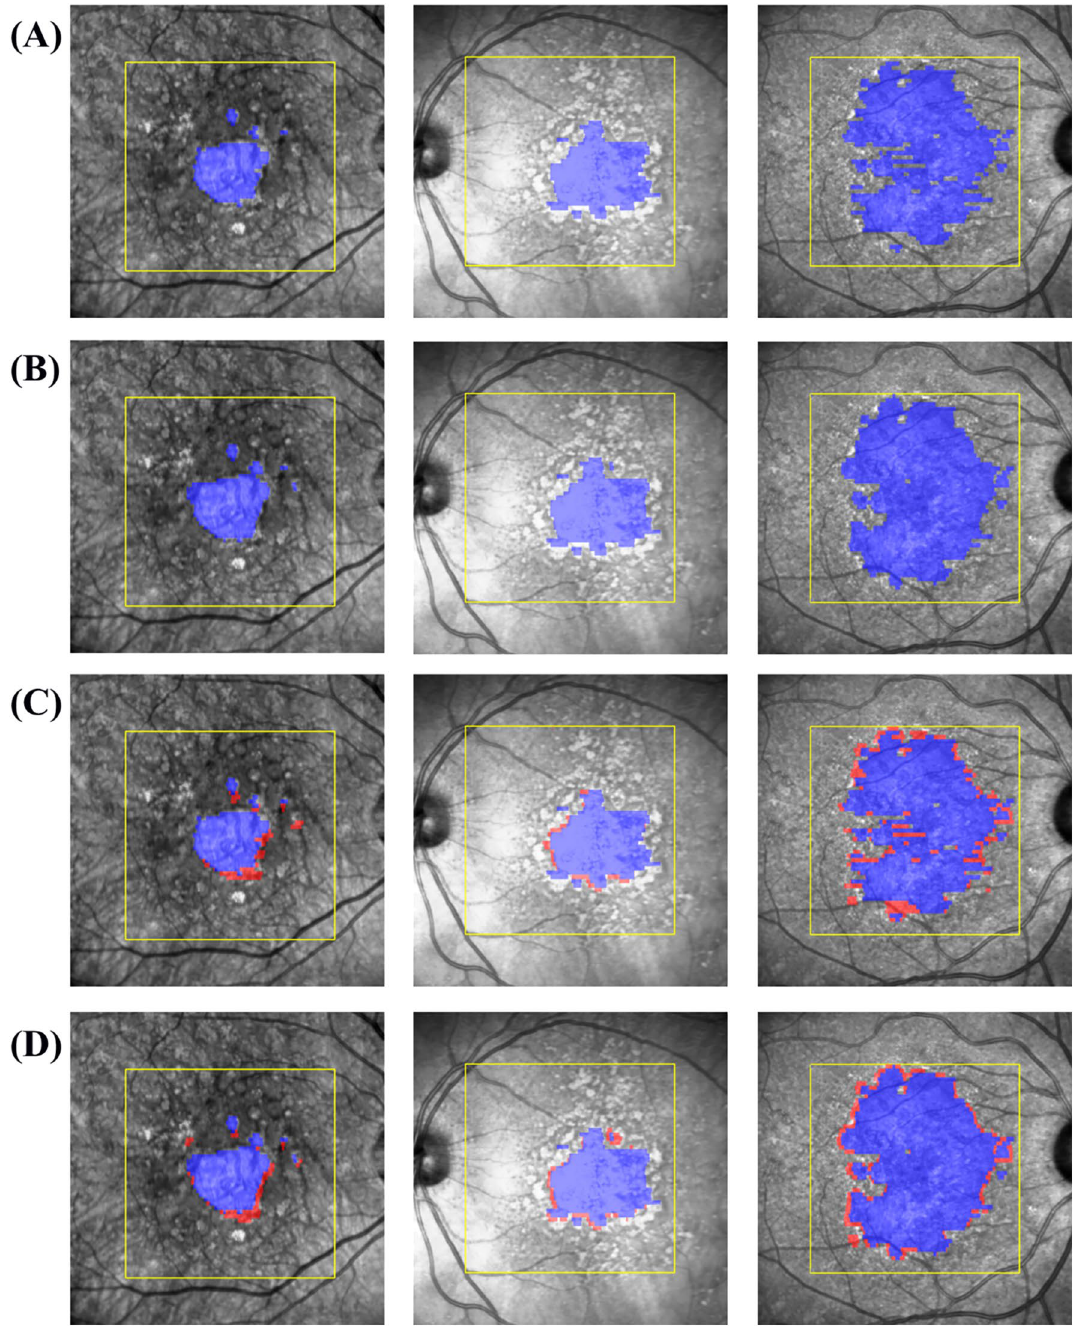
Figure 2. Examples of en-face segmentation of geographic atrophy on OCT of a small (first column), medium (second column) and large (third column) baseline lesion size, marked in blue. ( A ) represents the manually annotated baseline area, ( B ) represents the automatically segmented baseline area, ( C ) represents the manually segmented growth area at month 12, marked in red and ( D ) represents the automatically segmented growth area at month 12, marked in